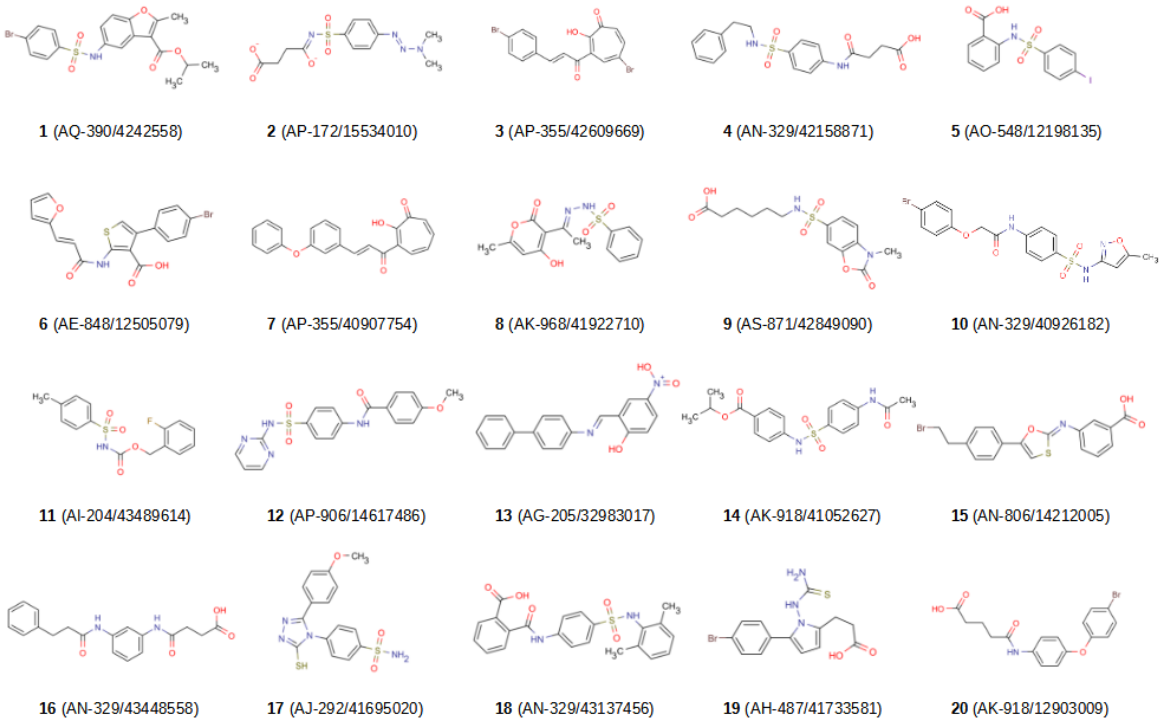
Figure 2. 2D structures of the 20 hit compounds. Each compound is identified with its Specs ID number. MarvinSketch [38] was used to draw the